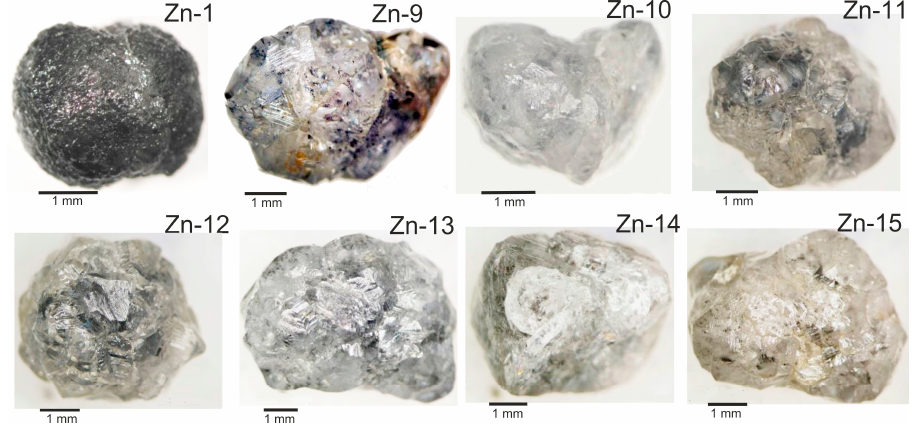
Figure 1. Rounded rough diamonds from Zarnitsa kimberlite pipe (optical microphotographs).